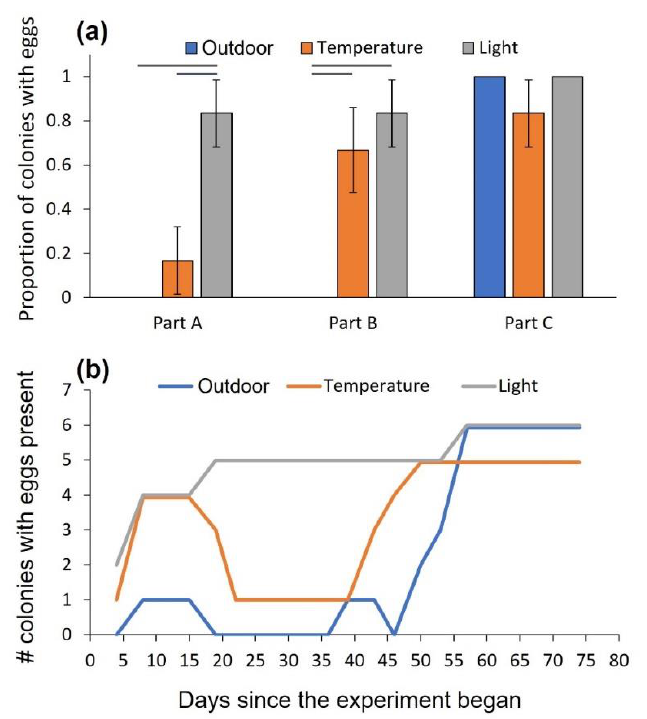
Figure 2. Experiment 1. ( a ) The proportion of colonies ( ± 1 SE) containing eggs at the end of each experimental part. Part A (days 1-24): decreasing temperature and shortening daylight. Part B (days 25-49): increasing temperature and elongating daylight back to the start point. Part C (days 50-74): uniform conditions in all treatments (only day-night fluctuations), bringing the treatment of the outdoor conditions inside the climate cabinet. None of the colonies in the outdoor treatment contained eggs in the first two experimental parts. Gray horizontal lines indicate significant differences between paired treatments. ( b ) The number of colonies producing eggs throughout the experiment as a function of days since its beginning.